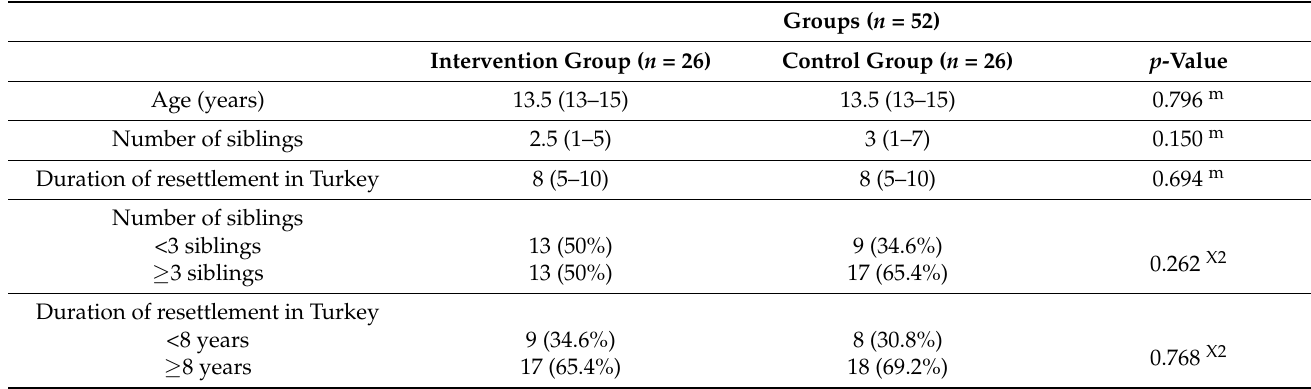
Table 1. General characteristics of the intervention and control